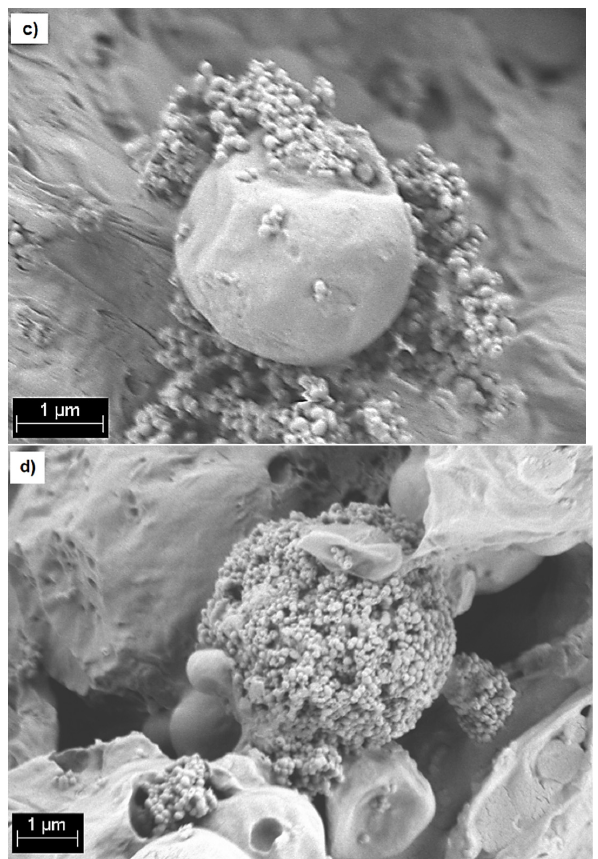
Figure 2. SEM micrographs of ( a ) blank PHBV microspheres; ( b ) PHBV/MBGN composite microspheres at 90:10 ratio, and PHBV/MBGN composite microsphere at higher ratios; ( c ) 60:40; and ( d ) 50:50.